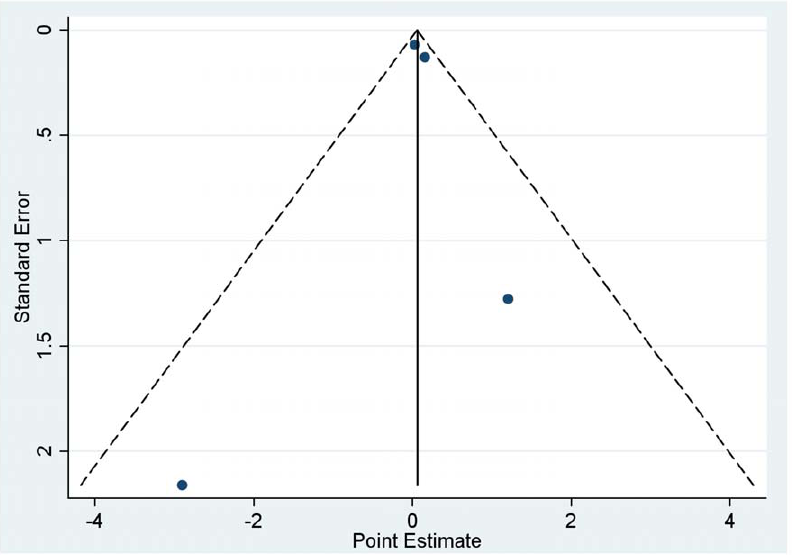
Figure 2. Funnel plot analysis of possible bias in the 4 studies included in the meta-analysis of the beta coefficient for diarrhea prevalence.